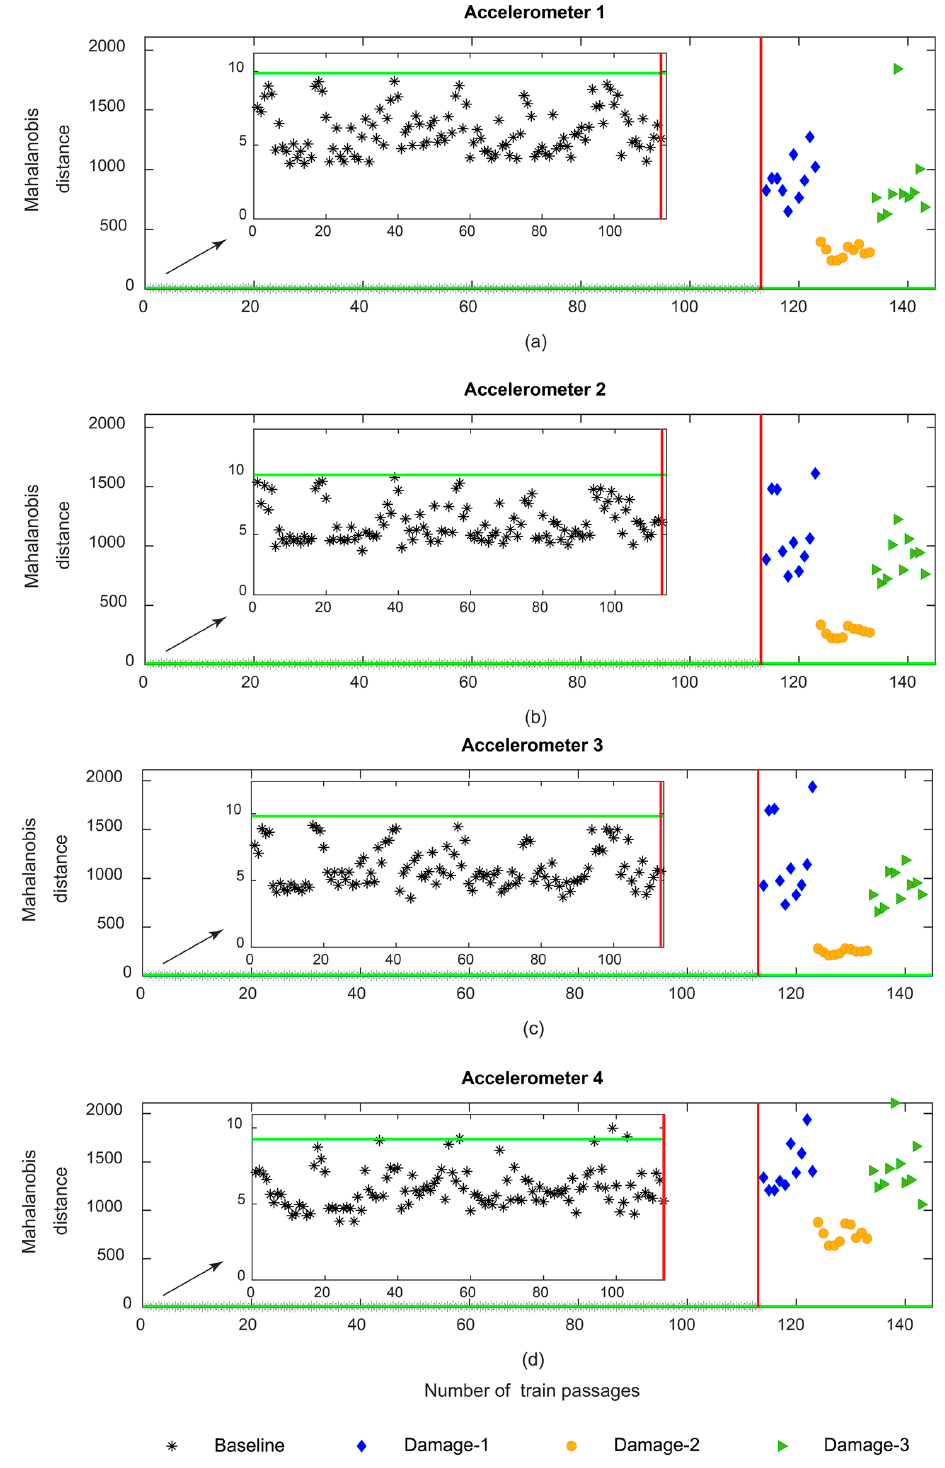
Figure 20. AR—automatic wheel flat damage detection considering the responses from accelerometers 1–4: ( a ) MD for accelerometer 1, ( b ) MD for accelerometer 2, ( c ) MD for accelerometer 3, ( d ) MD for accelerometer 4.